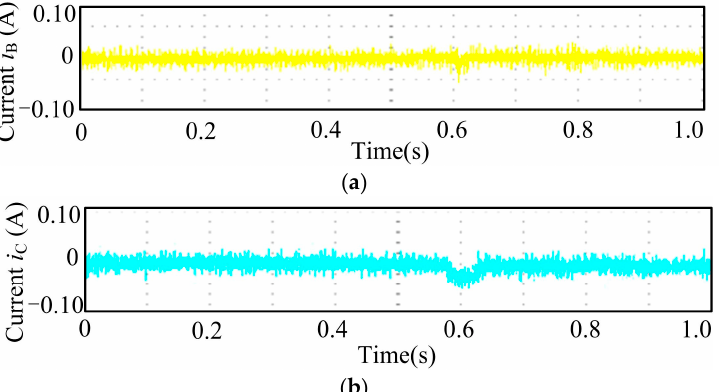
Figure 16. Experimental results in turning experiment. ( a ) Rotor offset in x direction. ( b ) Rotor offset in y direction.